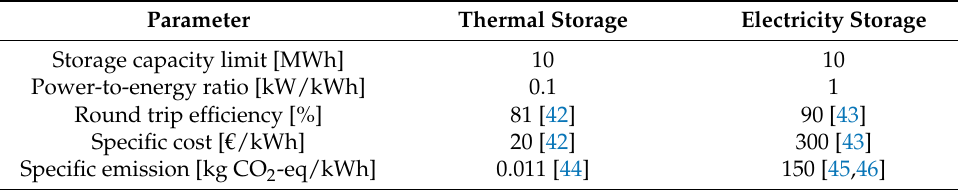
Table 4. Cost, emission, and performance parameters for on-site storage